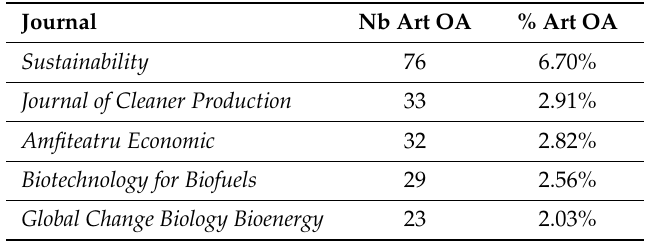
Table 9. The journals with the highest number and share of OA articles ( n = 1135).